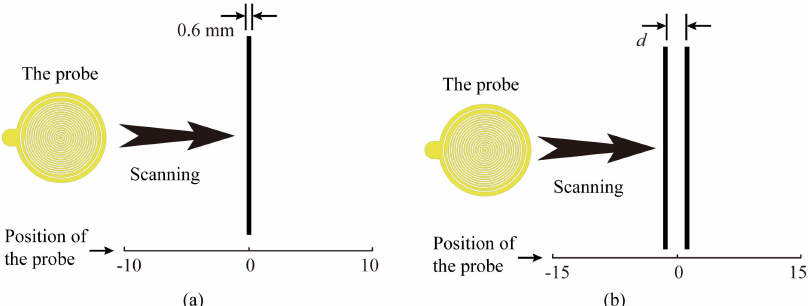
Figure 6. ( a ) The sketch of the sensitivity evaluation by the probe scanning a conducting wire; ( b ) The sketch of the resolution evaluation by probe scanning two adjacent conducting